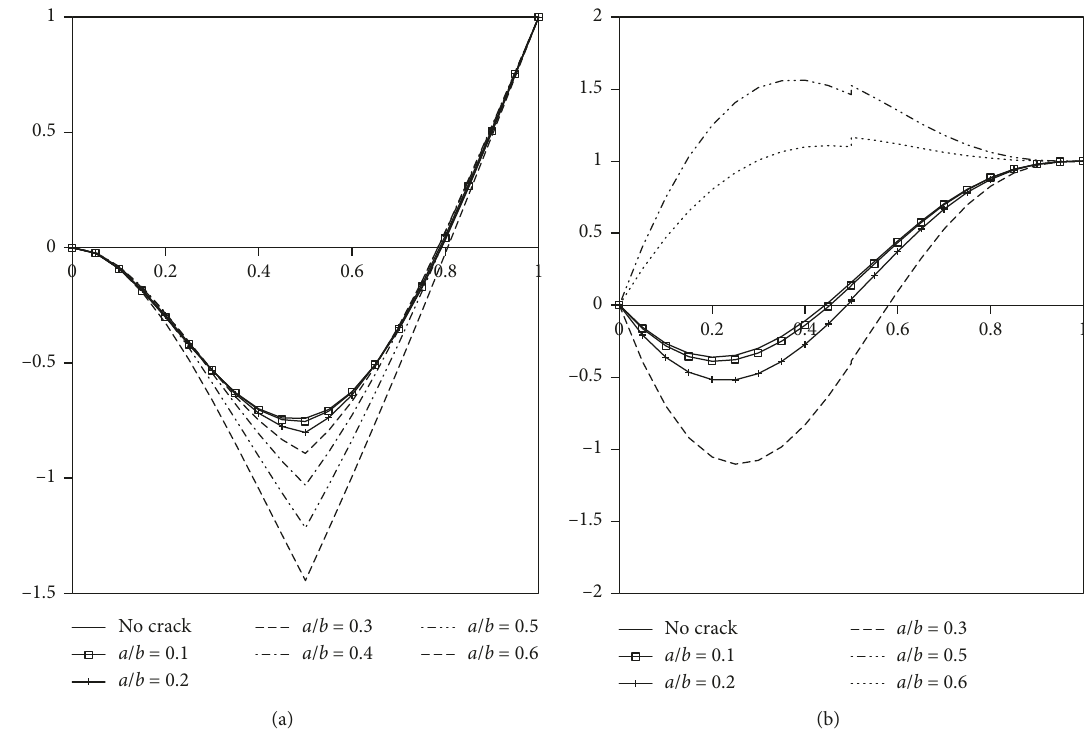
Figure 6: Second mode: (a) bending and (b) torsion of a composite beam with a crack located at 50% span and unidirectional ply angle of 70 °